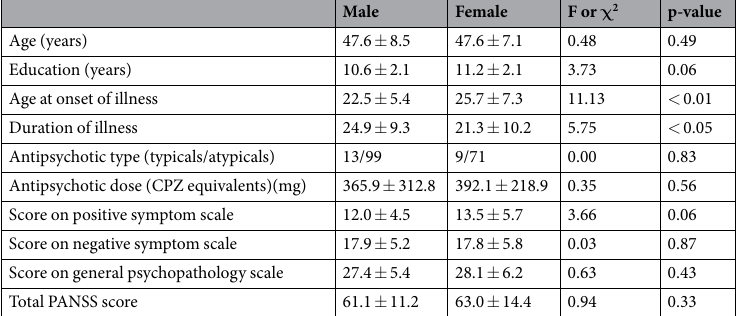
Table 2. Characteristics of patients with schizophrenia grouped by gender Note: Mean ± SD. CPZ = chlorpromazine; PANSS = the positive and negative syndrome